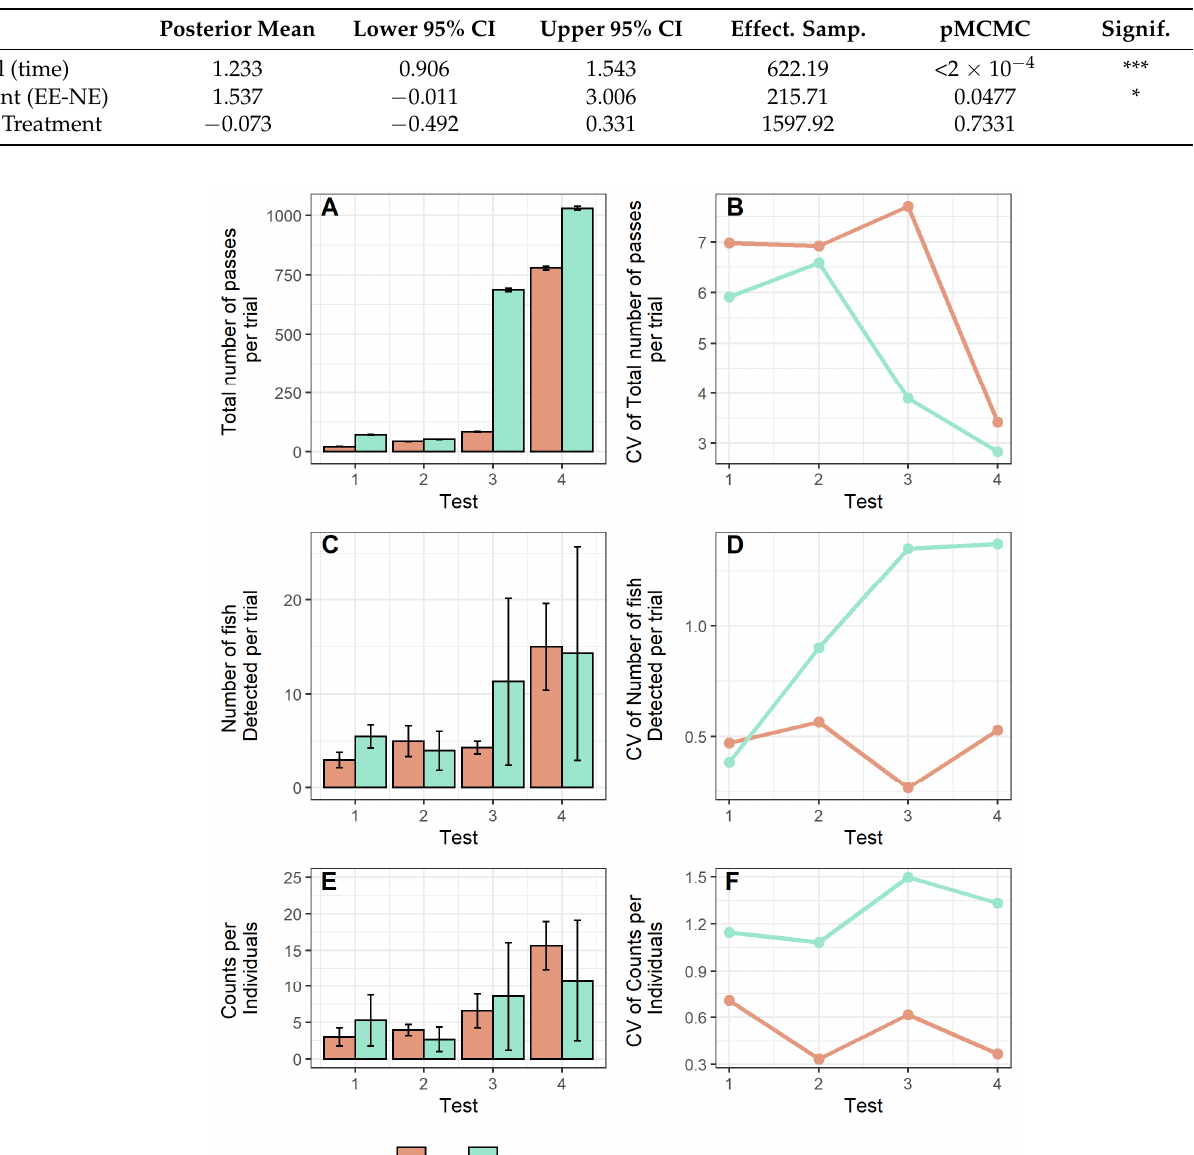
Figure 2. Resulting values from the risk-taking test of European seabass reared in enriched (EE) and non-enriched (NE) tanks regarding: ( A ) sum of total passes (±SD: standard deviation) detected in each consecutive test and ( B ) their respective coefficients of variation; ( C ) mean values (±SD: standard deviation) of fish detected in each consecutive test and ( D ) their respective coefficients of variation (CVs); ( E ) mean values (±SD: standard deviation) of passes detected per fish in each consecutive test and ( F ) their respective coefficients of variation (CVs).